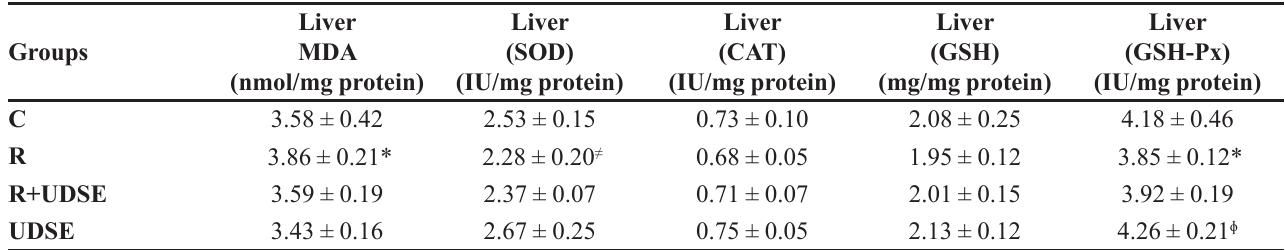
TABLE II - Actions of UDSE on selected antioxidant enzyme activities and MDA in the liver tissue of rats